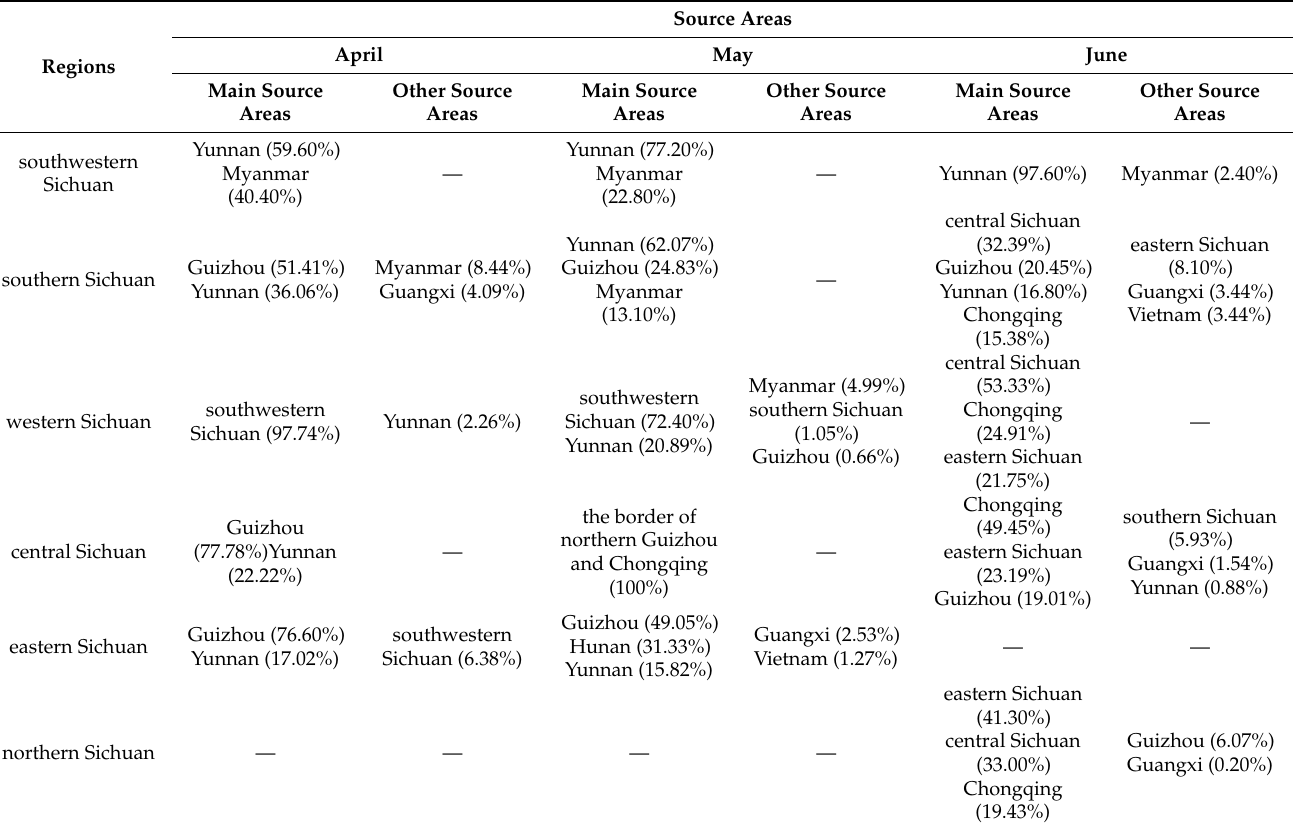
Table 1. The distribution probability of the FAW backward trajectory endpoints in different regions of Sichuan Province from April to